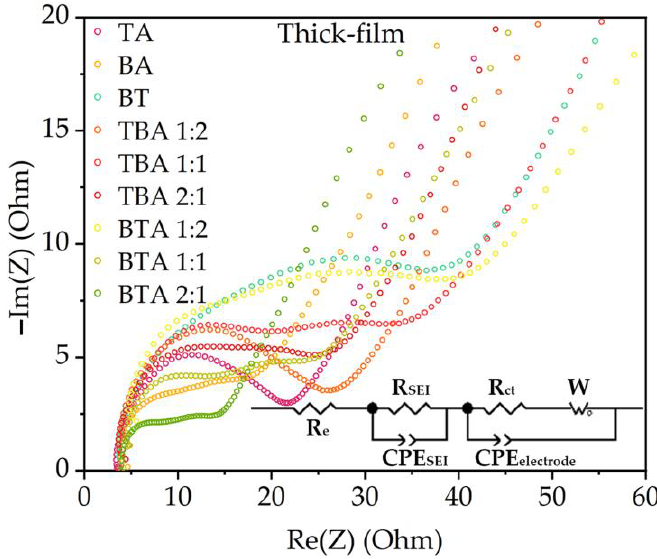
Figure 6. The EIS measurements of the coin cells with various hierarchical structured electrodes and the equivalent circuit model.